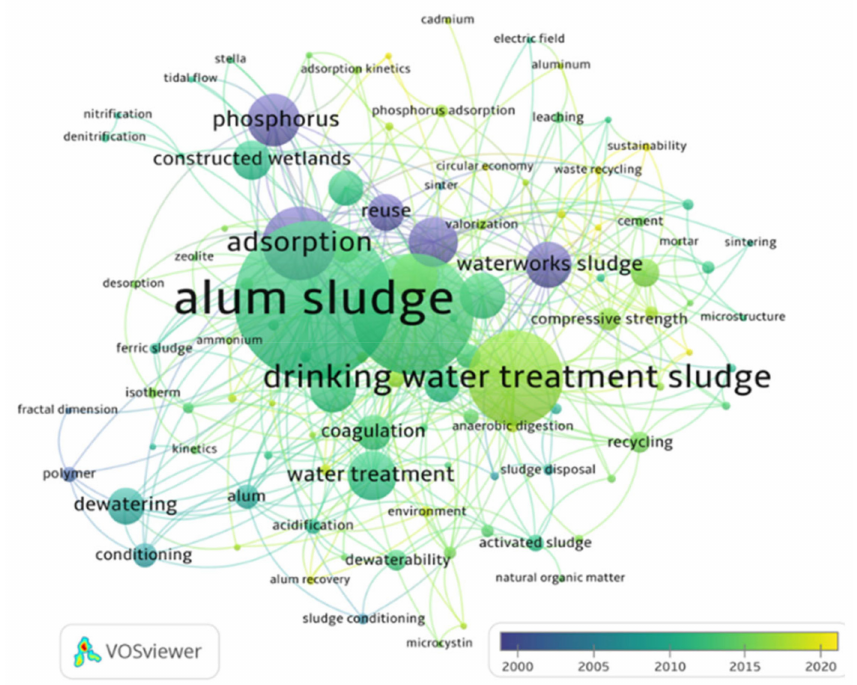
Figure 2. Bibliometric map generated based on density visualization of research trends in the last 20